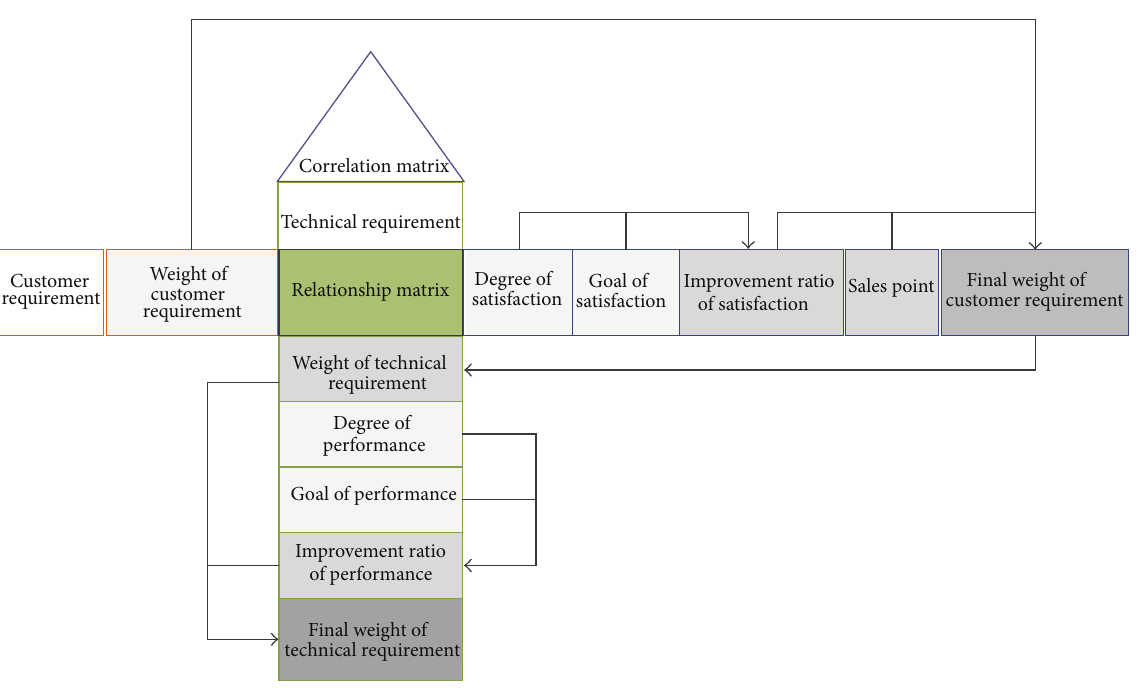
Figure 5: The sketch of the House of